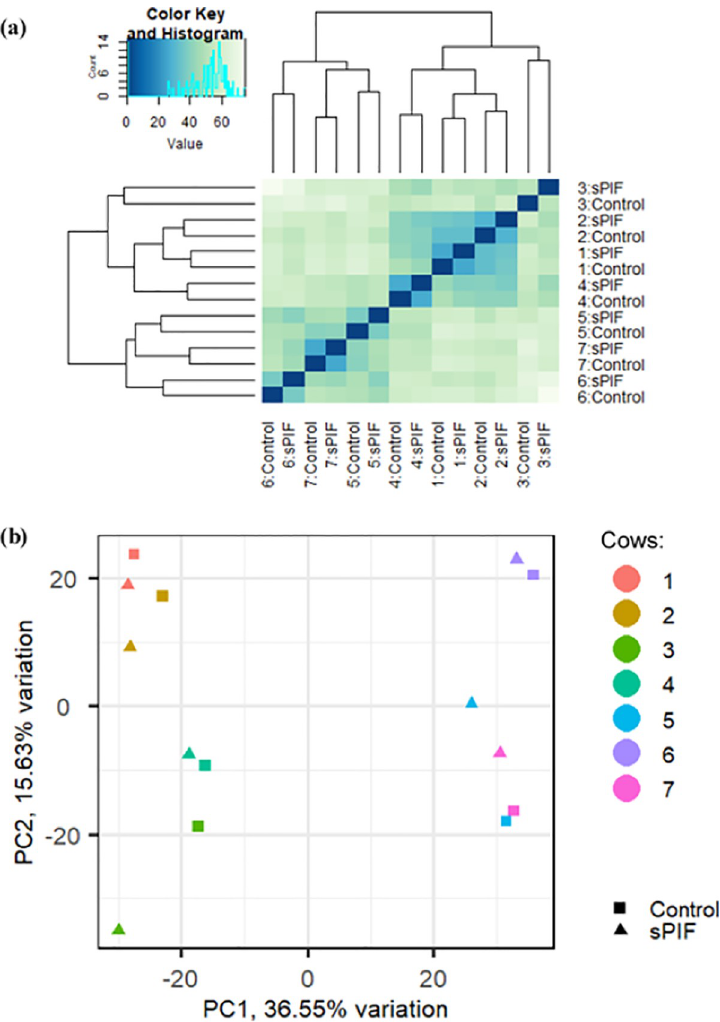
Fig 1. Large variances were detected between samples. (a) Heat map depicting the Euclidian distances between individual animal replicates and samples treated with or without sPIF (100nM), calculated from the regularised log transformation. (b) PCA plot showing the variance between individual animal replicates and samples treated with or without sPIF (100nM) in the first two principle components.